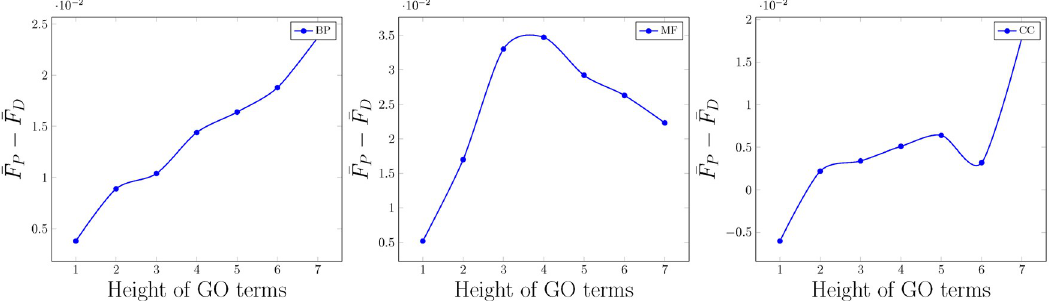
Fig 3. Differences between average F1 obtained for PFP-WGAN and DeepGO-Seq for the GO terms in each height ( � F In the BP branch (as the most important part of GO with a large number of terms) differences are increased when moving through the deeper terms. In the most and half parts of the charts for CC and MF branches we can observe this pattern